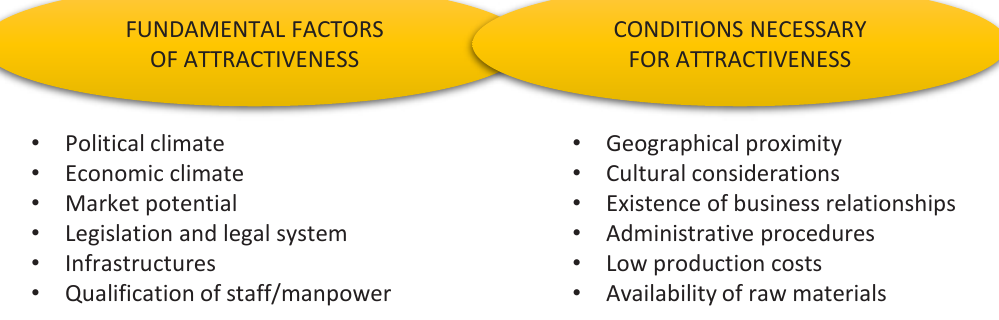
Figure 1. Territorial attractiveness factors according to Michalet (1999)